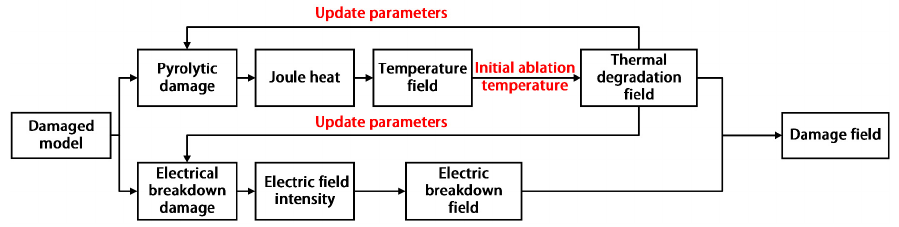
Figure 4. Flow chart of the calculation for the lightning damage model.